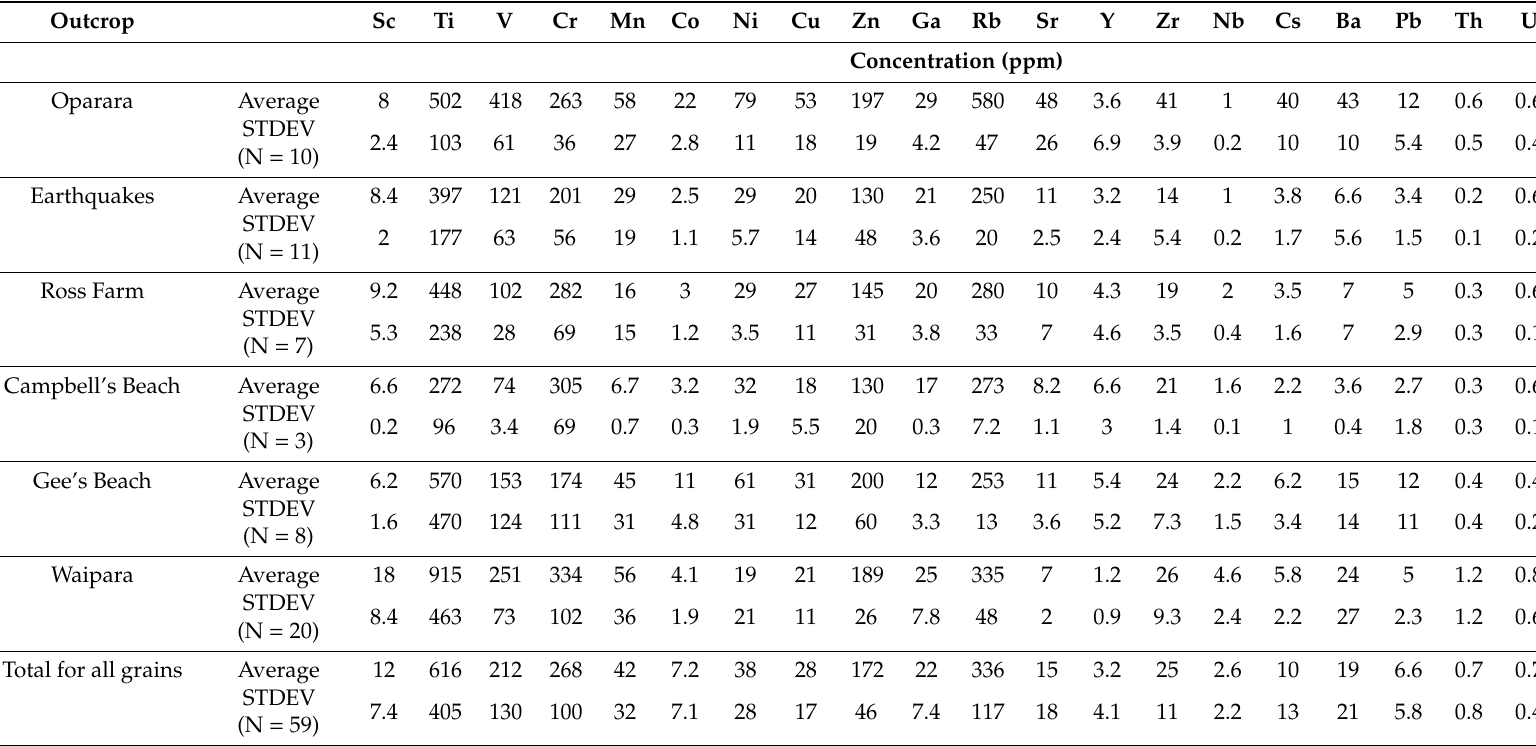
Table 4. Trace element averages and standard deviations for all grains measured by laser ablation induction coupled plasma mass spectroscopy (LA-ICP-MS).